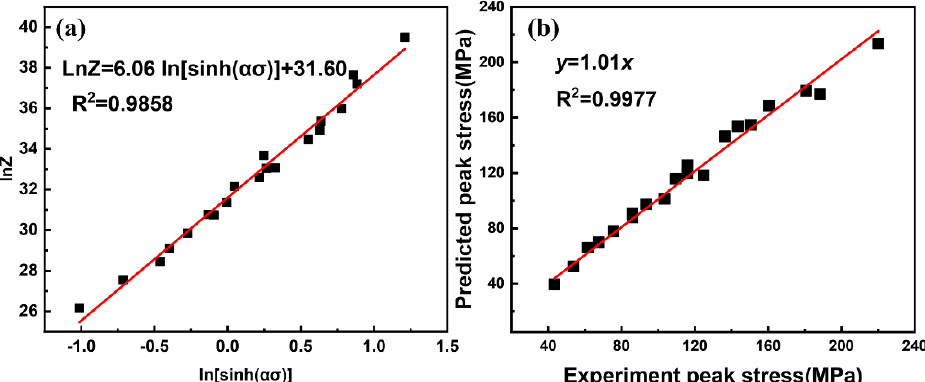
Figure 6. The linear relationships for different parameters of the studied alloy ( a ) ln 𝜺̇ versus lnσ ; ( b ) ln 𝜀̇ versus σ ; ( c ) ln 𝜀̇ versus ln [ sinh(ασ) ]; ( d ) ln [ sinh(ασ) ] versus 1000/ T .